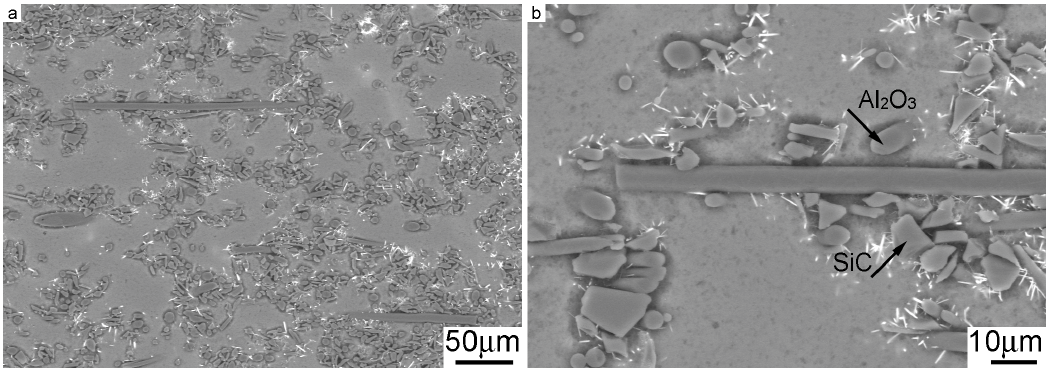
Figure 3. The microstructure (BSE mode) of the hybrid composite ( a ); a closer view of a fiber surrounded by SiC particles ( b ).